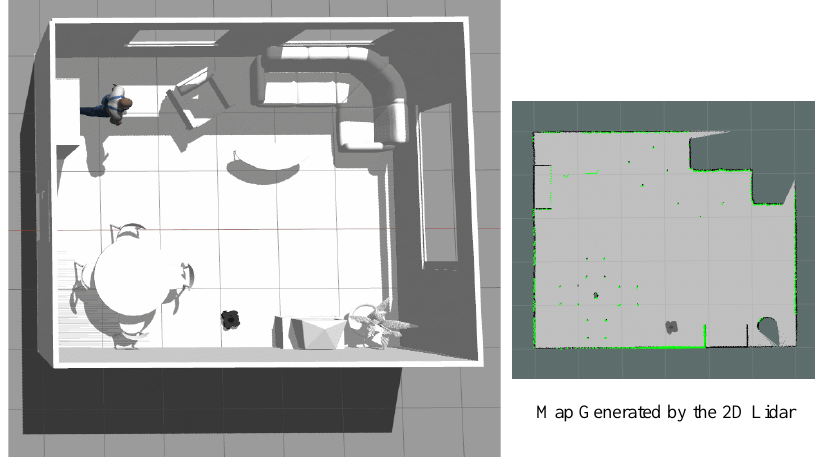
Figure A2. An example of the Lidar’s generated map with different